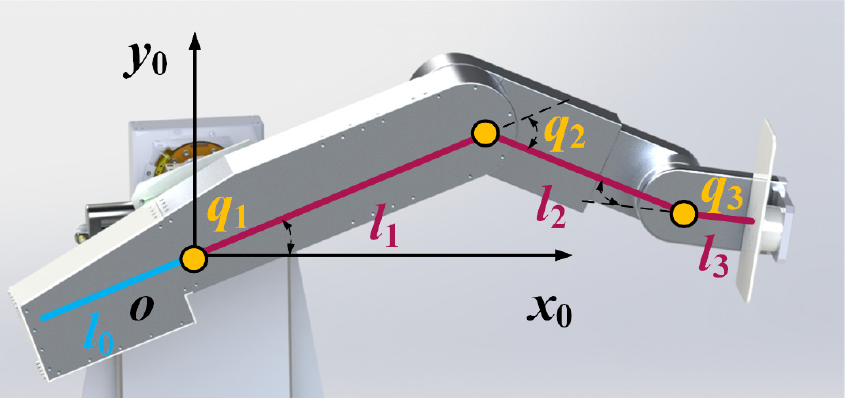
Figure 2. The mechanical leg has three joints which correspond to hip, knee, and ankle joints, respectively ( q 1 , q 2 , and q 3 represent the joint variables). Each joint equips with an angular transducer. A six-axis force sensor is assembled under the end pedal. The length between two adjacent joints (i.e., l 1 or l 2 ) can be adjusted by the linear actuator inside of the mechanical leg, so this device can adapt to people with different heights. The global frame o - x 0 y 0 is located on the first joint. The blue line represents the counterweight part, and its gravity lever arm depends on the position of the first joint (i.e., the proportion of length l 0 and length l 1 is adjustable).